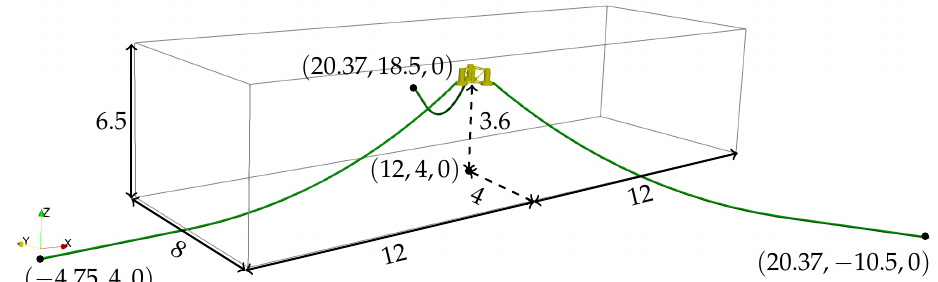
Figure 13. Computational domain and mooring system for the simulation of a moored, floating offshore wind turbine in waves.